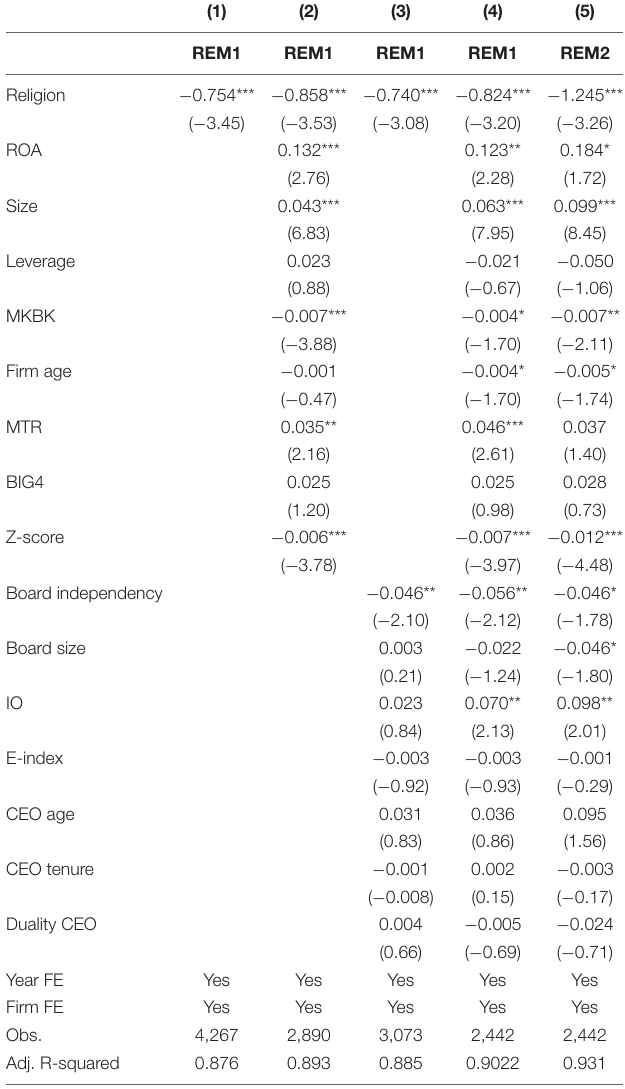
TABLE 2 | Religion and real earnings management